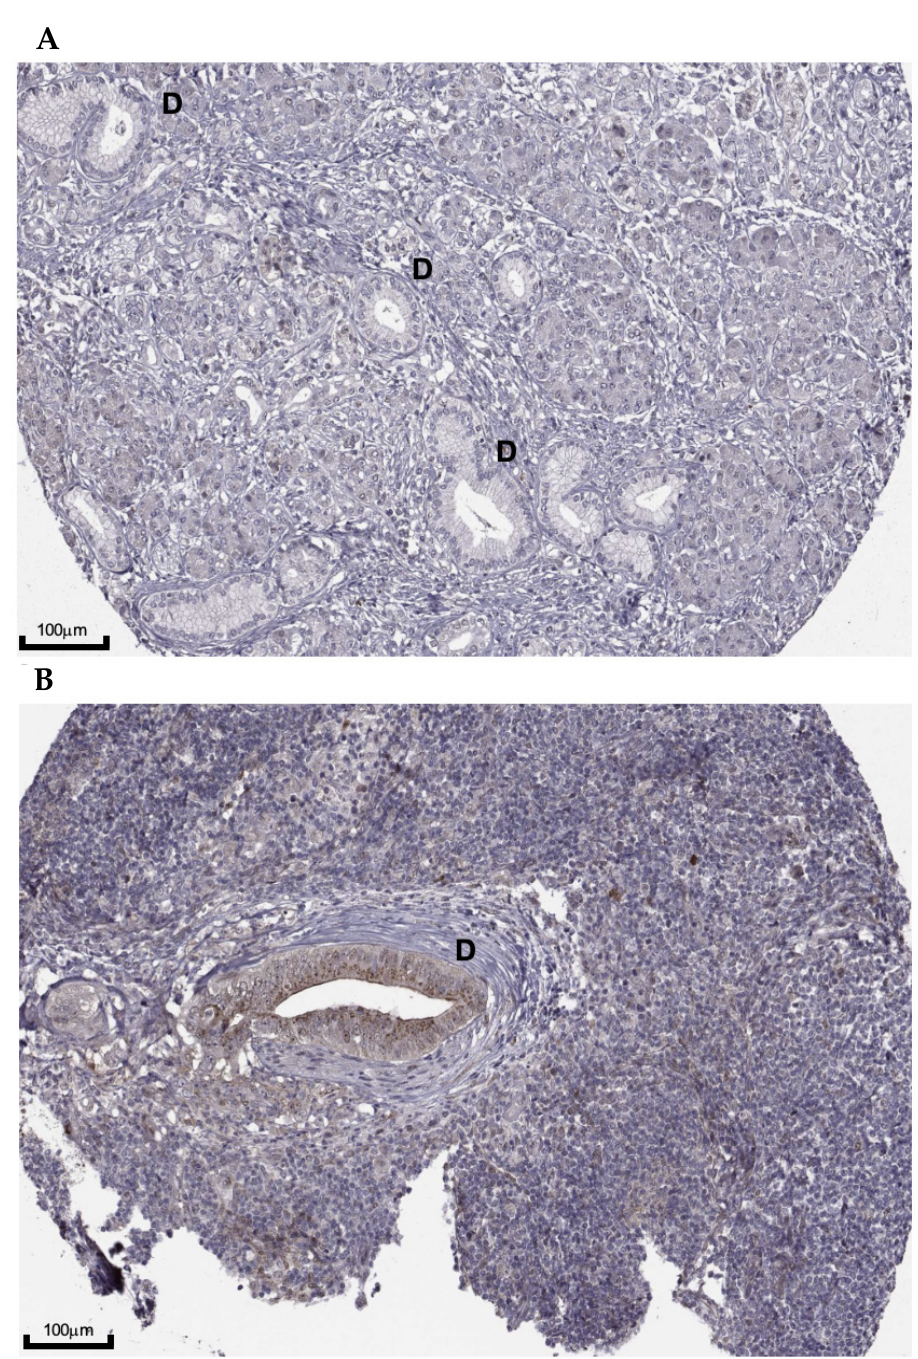
Figure 7. Histological slides from two pancreatic ductal adenocarcinoma patients both stained with a monoclonal antibody for CDK4-CAB069405 (AbFrontier). ( A ) Slide shows no staining detected, with negative intensity, 0% of cells stained and no staining within the cells (scale bar—100mm) ( B ) Slide shows high levels of staining, with strong intensity, 25–75% of cells stained and evidence of staining within the nucleus, cytoplasm and membrane (scale bar—100mm). D = Interlobular duct. Image credit: Human Protein Atlas, image available from vv20.1.proteinatlas.org (accessed on 6 June 2021) [23].